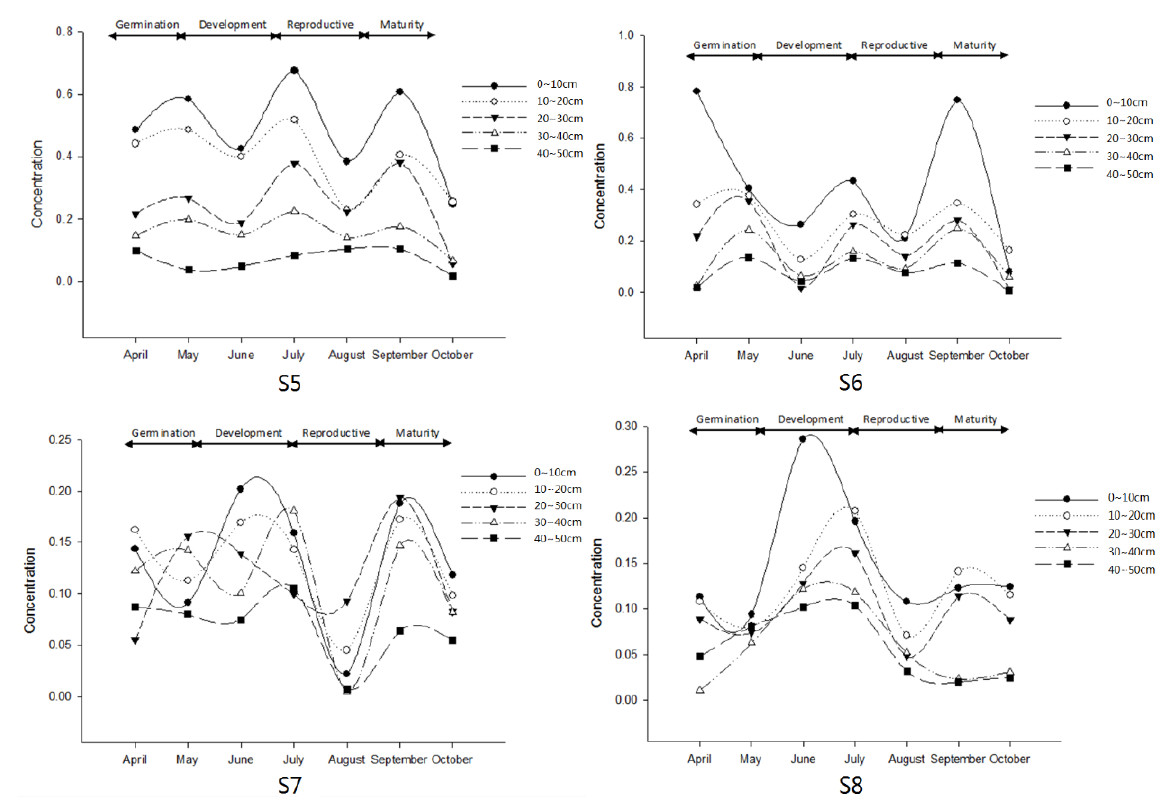
Figure 2. Vertical Distribution of TP content at each site(S1 – S8).